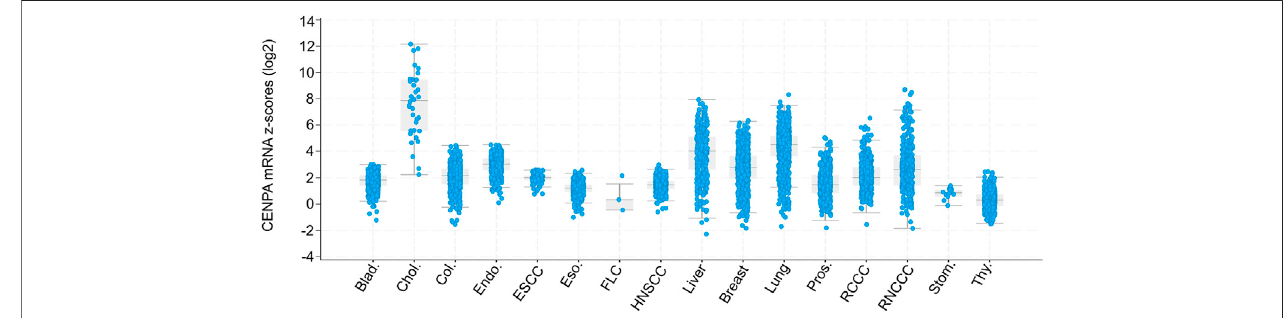
FIGURE 2 | Box and dot plots indicating CENPA expression in patient tumors relative to normal samples (z-score, log2 RNA SeqV2 RSEM). Modi fi ed from Jeffery etal.,2021 . BoxanddotplotsindicatingCENPAmRNAexpressionlevelsinpatienttumorsrelativetonormalsamples(z-score,log2RNASeqV2RSEM)fromcBioPortal (TCGA PanCancer Atlas studies) (Cerami et al., 2012; Gao et al., 2013). The plot was generated using the cBioPortal web interface. X-axis indicates Cancer Type: Bladder UrothelialCarcinoma (Blad.),Cholangiocarcinoma(Chol.),ColorectalAdenocarcinoma(Col.),EndometrialCarcinoma(Endo.),EsophagealSquamousCell Carcinoma (ESCC), Esophagogastric Adenocarcinoma (Eso.), Fibrolamellar Carcinoma (FLC), Head and Neck Squamous Cell Carcinoma (HNSCC), Hepatocellular Carcinoma (Liver), Invasive Breast Carcinoma (Breast), Non-Small Cell Lung Cancer (Lung), Prostate Adenocarcinoma (Pros.), Renal Clear Cell Carcinoma (RCCC),